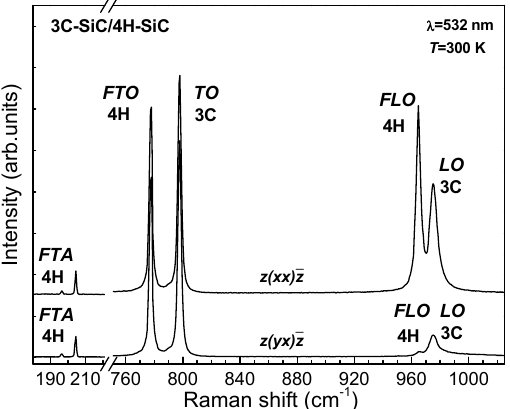
Figure 1. Polarized Raman spectra of 3 C -SiC/4 H -SiC heterostructure before the proton irradiation. The carrier concentration and mobility were found from the Hall effect after each irradiation